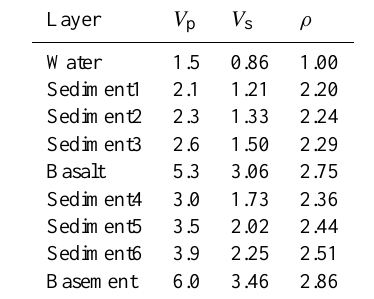
Table 1. Velocities and densities used in the synthetic model. Phys- ical properties were taken from Carmichael (1982). The Poisson ratio was 0.25 and the density was calculated using the Christensen relation Christensen and Mooney (1995): ρ = 1 . 85 + 0 . 169 V p .